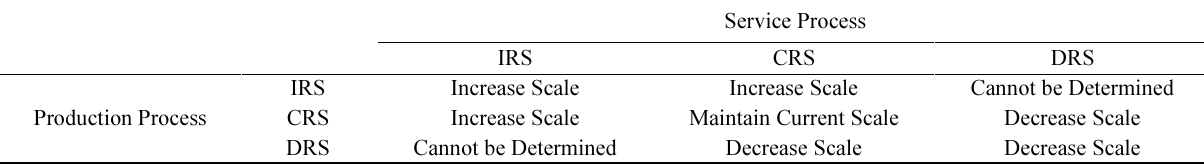
Table 2. Actions responsive to the relationship returns to